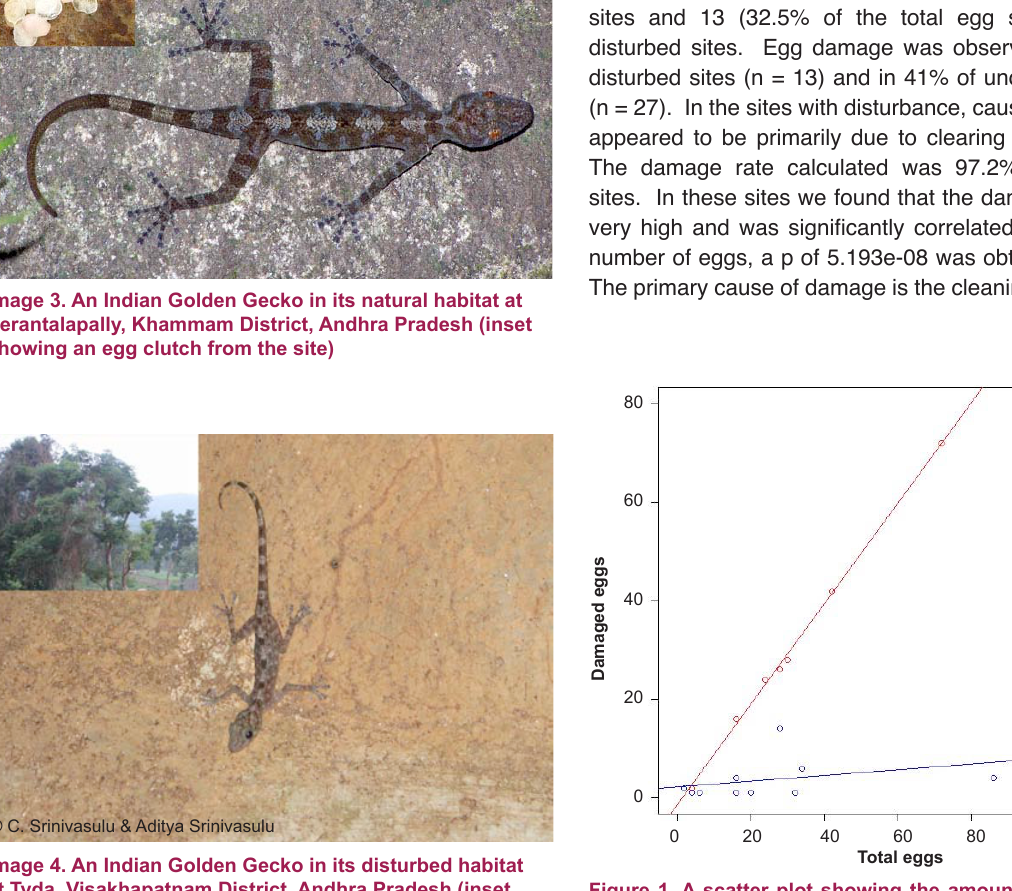
Figure 1. A scatter plot showing the amount of damage in disturbed (red) and undisturbed (blue)